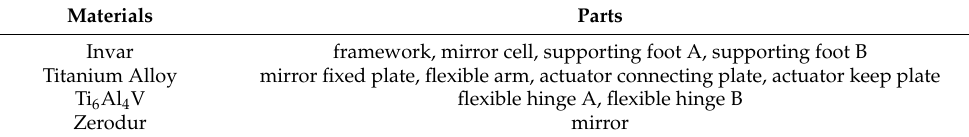
Table 1. Materials of parts.